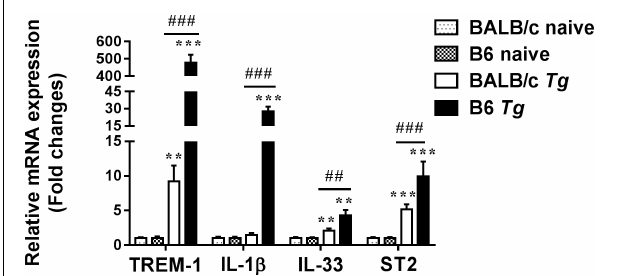
FIGURE 4 | The mRNA expressions of TREM-1, IL-1 β , IL-33, ST2, and TREM-2 in the eyes of naive mice and T. gondii -infected mice were measured by using qRT-PCR. Data are presented as means ± SD; there were six mice in each group and the data represents from two experiments. ∗∗ P < 0.01, and ∗∗∗ P < 0.001, T. gondii -infected mice vs. naive mice. ## P < 0.01, ### P < 0.001, T. gondii -infected B6 mice vs. T. gondii -infected BALB/c mice.